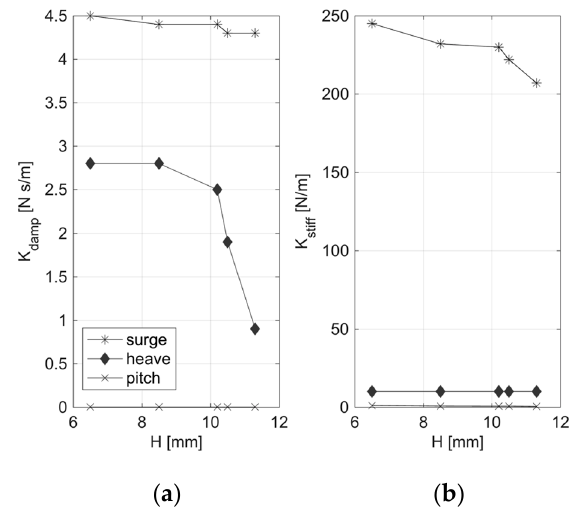
Figure 10. Calibrated values for the mooring system against the tested wave heights (R03-R08): damping ( a ) and stiffness ( b ) coefficients for each DoF.